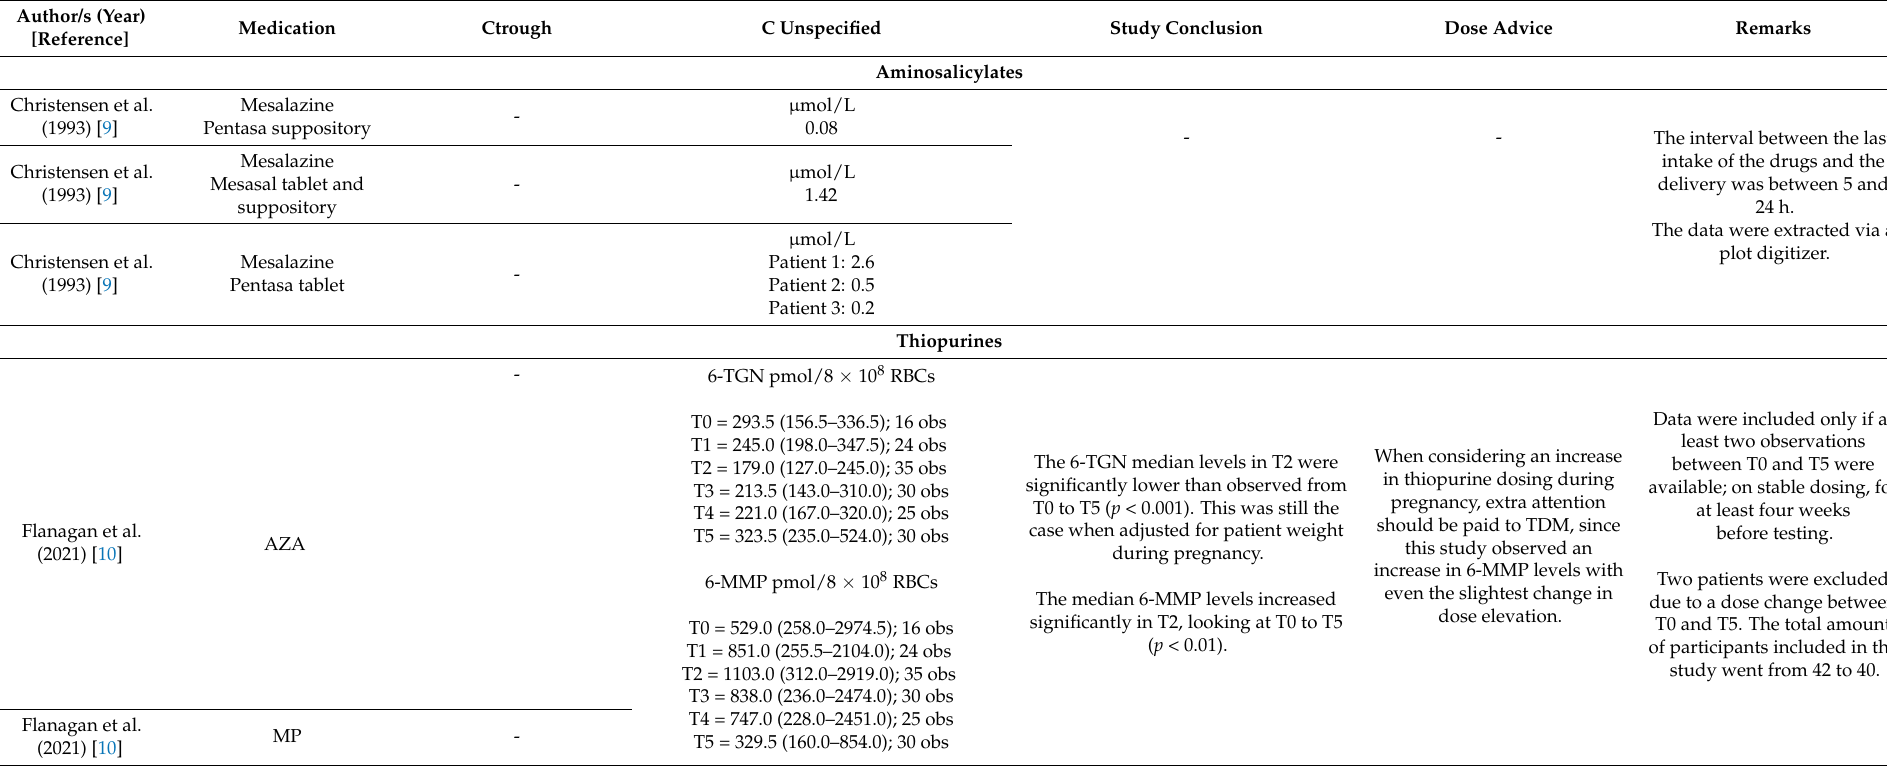
Table 2. Summary of the pregnancy-induced changes in the pharmacokinetics of IBD-related drugs. The data are presented as mean (SD), median (IQR) or alternative method, indicated next to the corresponding value. Each row is dedicated to a medicine. When a column overlaps multiple rows, the data are shared over multiple